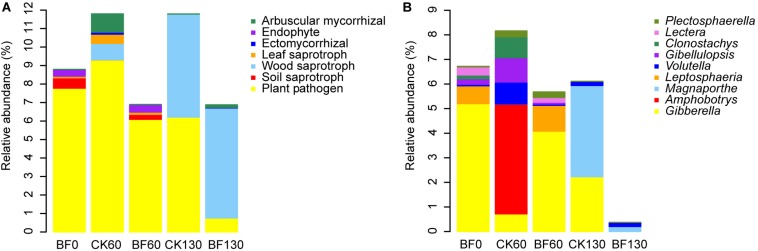
Relative abundance of fungi. (A) fungal ecological guild; (B) the relative abundance of plant pathogen.